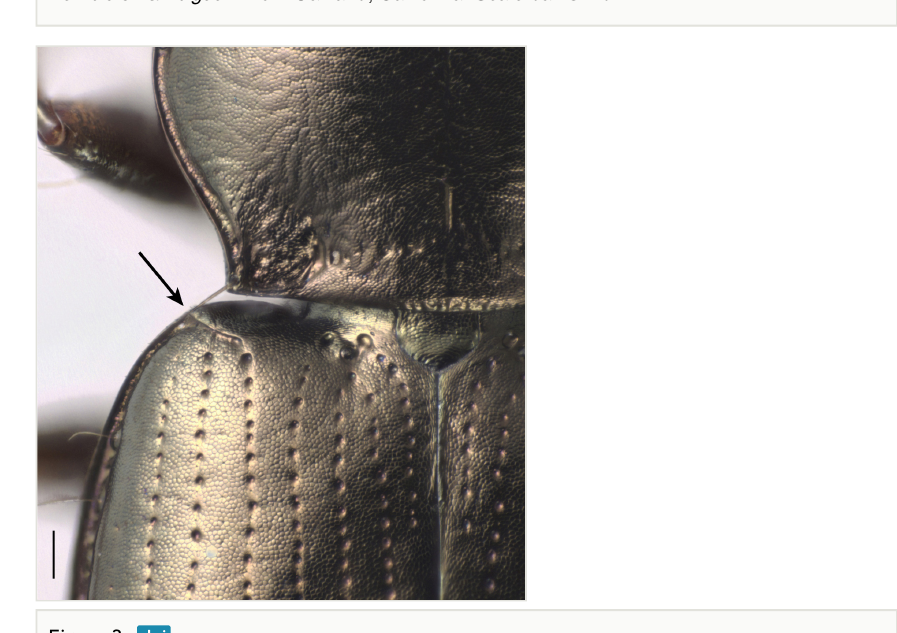
Figure 1. Bembidion ambiguum from Oakland, California. Scale bar is 1.0 mm.